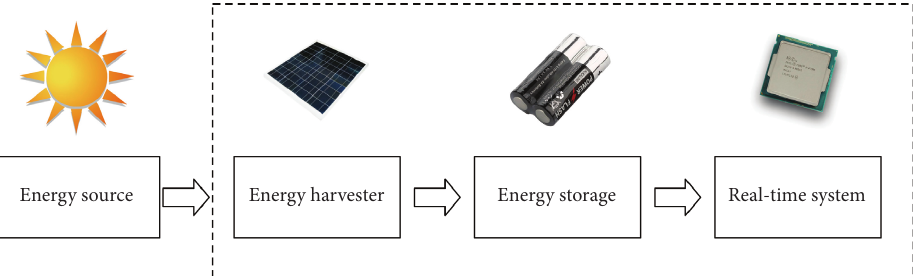
Figure 1: Energy-harvesting embedded system